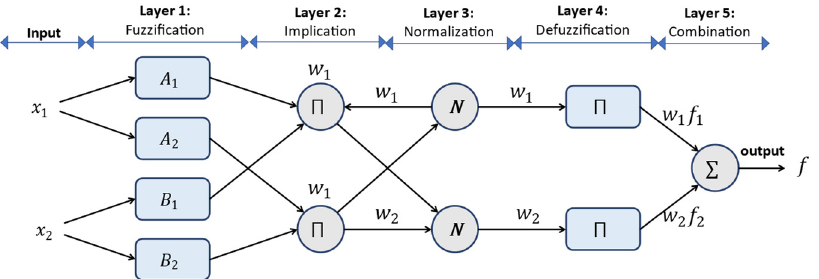
Figure 2. ANFIS Structures. 𝓍 Figure 2. ANFIS